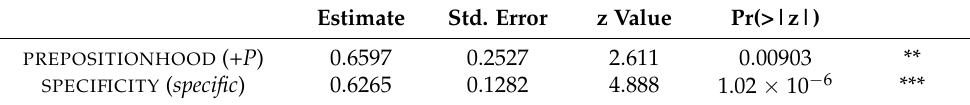
Table 2. Mean acceptability ratings in Experiment 1.